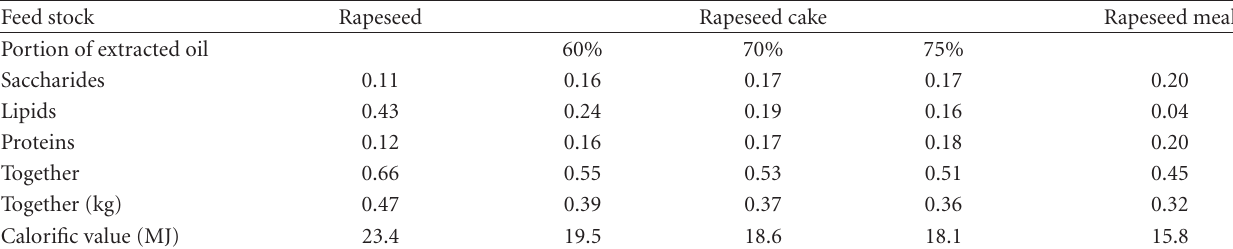
Table 5: Methane production potential from rapeseed, rapeseed cake and meal in m 3 /kg VS